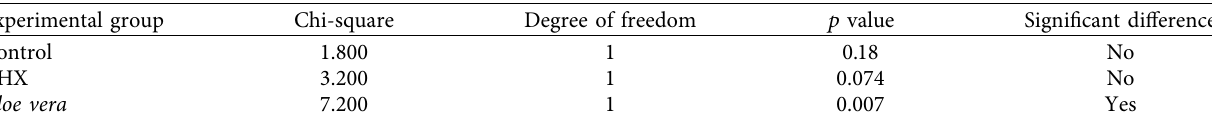
Table 2: Statistical difference between failures and successes after 18